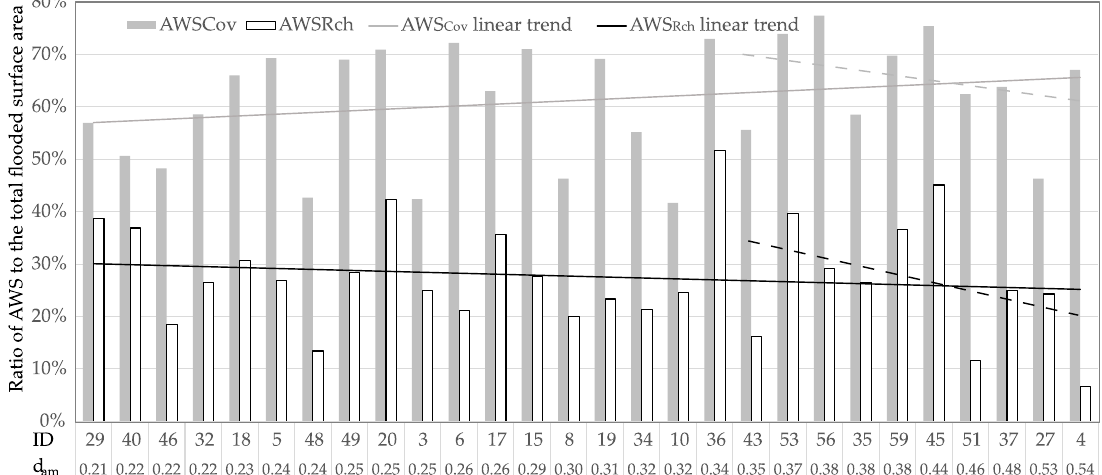
Figure 7. Comparison of the ratio of AWS Cov and AWS Rch to the total flooded surface area: the reaches are arranged according to d am from 0.21 m to 0.54 m. For d am from 0.35 m to 0.54 m, the trend line is depicted by the grey dashed line ( AWS Cov ) and the black dashed line ( AWS Rch ).